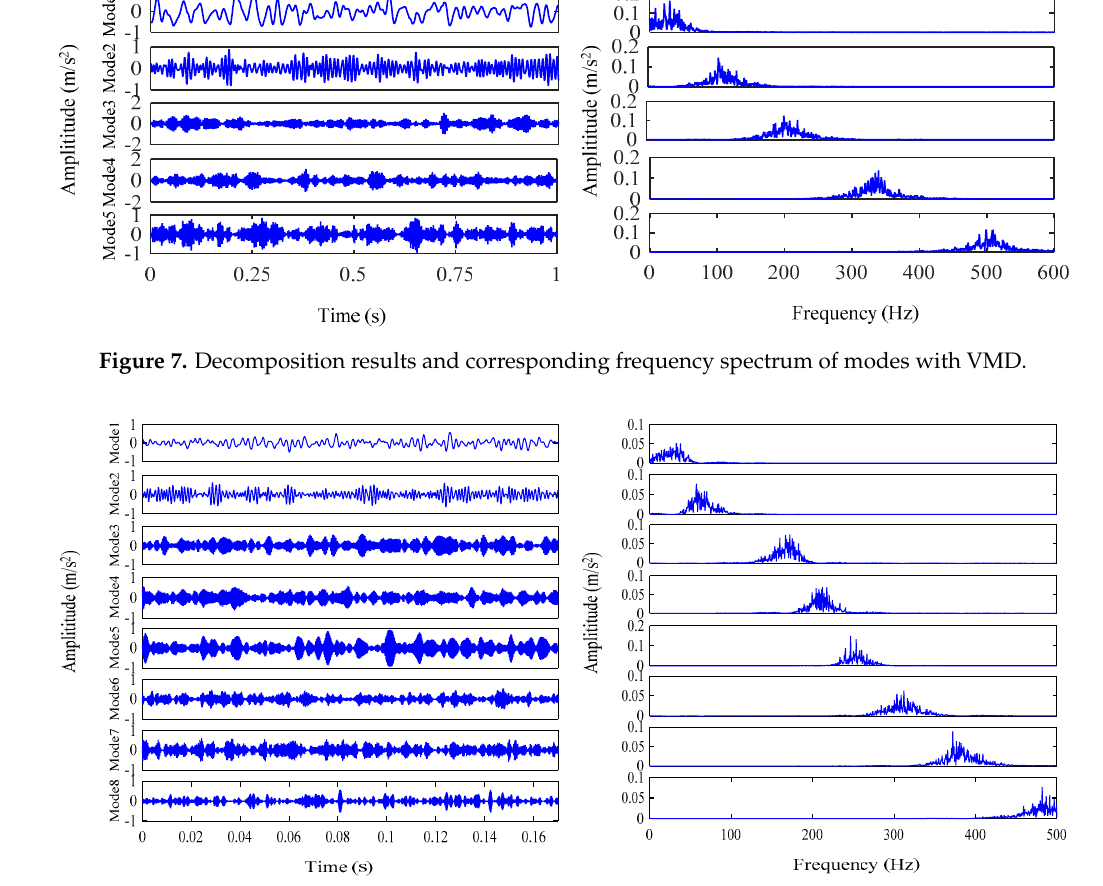
Figure 6. Decomposition results and corresponding frequency spectrum of IMFs with complementary ensemble empiri- cal mode decomposition (CEEMD).